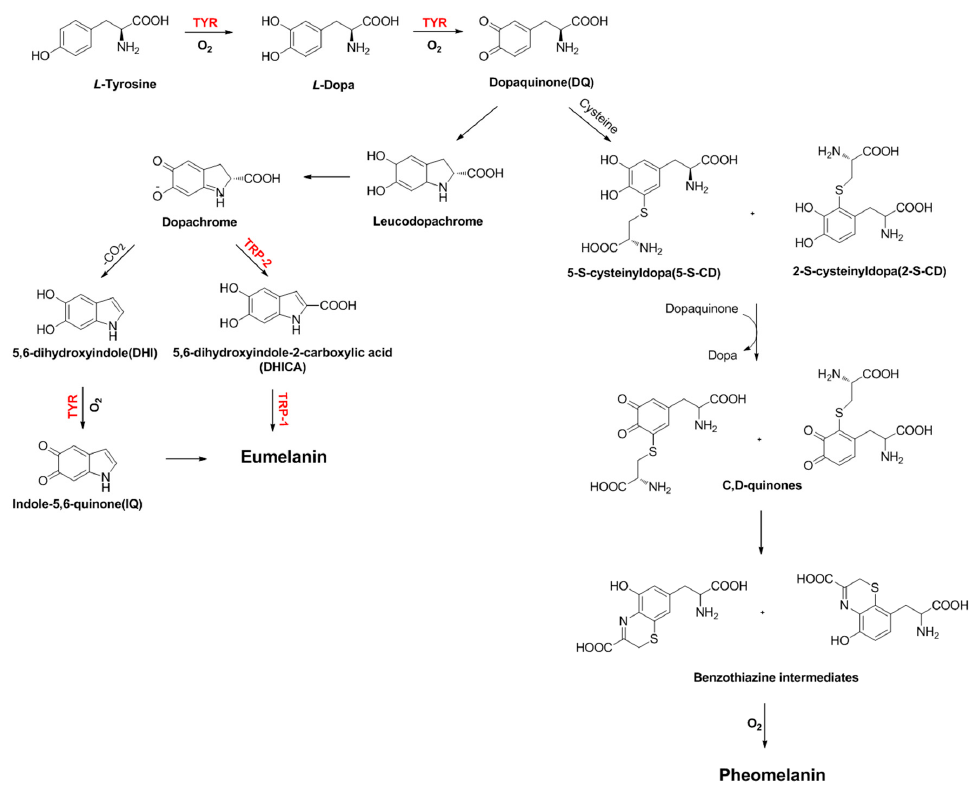
Scheme 1. Melanogenesis catalyzed by tyrosinase (TYR), tyrosinase-related protein 1 (TRP-1) and